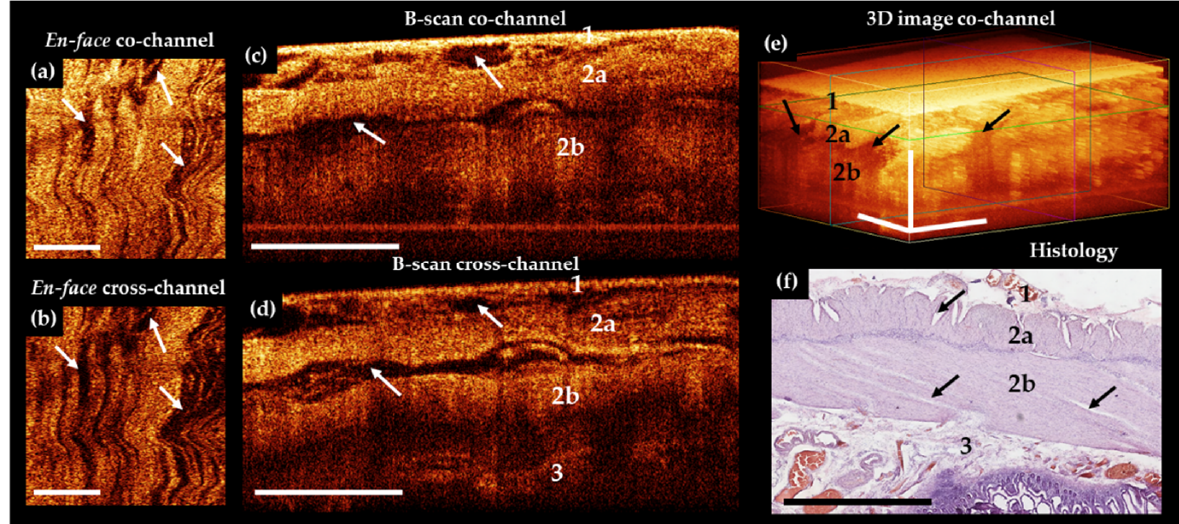
Figure 4. Representative trans-serosal CP OCT images of ischemic ileum without necrosis. ( a , d ) In the B-scans co– c ) and cross–( d ) channels and in 3D OCT image ( e ) the general architecture of the serous membrane (1) and muscularis externa (outer longitudinal—2a and inner circular—2b layer of smooth muscle) are clearly resolved with the extensive accumulation of intermuscular fluid (white and black arrows) within each layer. The boundary between the circular muscular layer (2b) and the submucosa (3) is more clearly visible in the B-scan cross—image ( d ). ( a , b ) En-face OCT images at the level of the longitudinal muscular layer (green horizontal line in ( e )), intermuscular spaces (white arrows) are longer and wider than in norm (Figure 3a,b). ( f ) Corresponding histological image, H&E staining. Black arrows indicate intermuscular edema. Scale bars 1 mm.